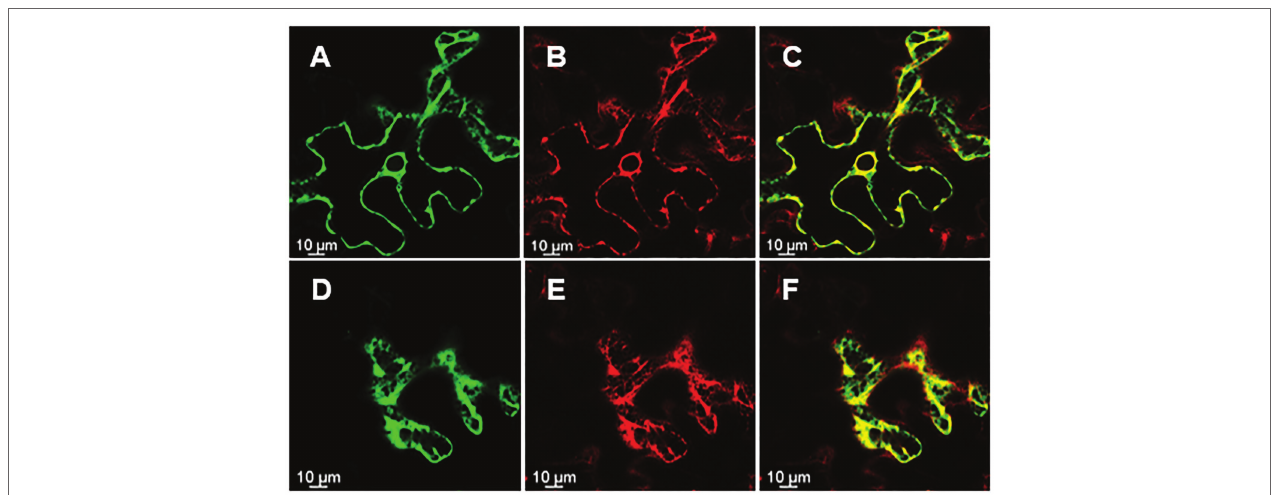
FIGURE 8 | rolC with N-terminus eGFP tag visualized by confocal microscopy of N. benthamiana epidermal leaves. (A) rolC with eGFP tag on its N-terminal end localizes to the nuclear membrane (B) mRFP1 fused to SbCYP89A1. (C) Overlay of signals from eGFP-rolC and SbCYP89A1-mRFP1 demonstrating co-localization of both proteins on the nuclear membrane. (D) eGFP-rolC appears soluble filling the cytoplasm (E) Sb-CYP89A1-mRFP1 localizes to the ER membrane network; (F) is an overlay of signals from eGFP-rolC and SbCYP89A1-mRFP1 showing differential localization of both